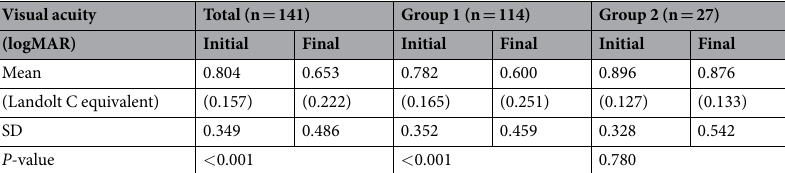
Table 4. Initial versus final visual acuity in 141 eyes with documented visual acuity before and after treatment with ranibizumab. Group 1 includes the eyes approved by the national health insurance system on only one application. Group 2 includes the eyes approved on the second application (n = 26) or third application (n = 1). logMAR, logarithm of the minimum angle of resolution; SD, standard